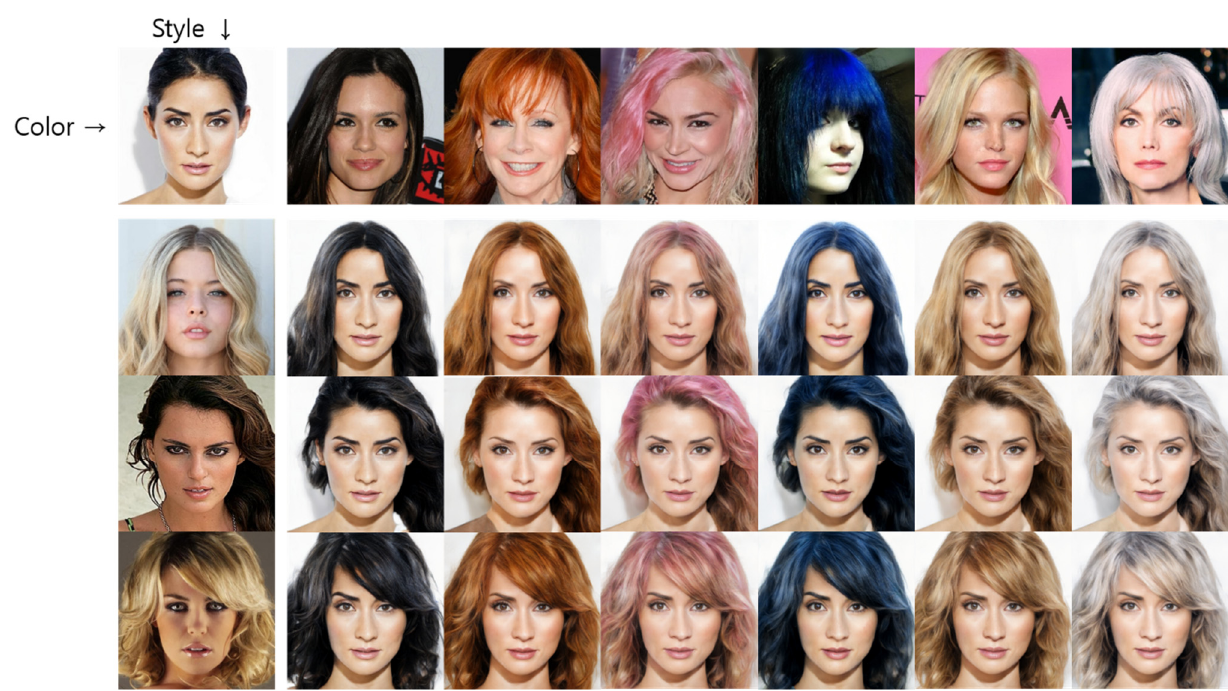
Figure 12. Left image: style; top image: color. High-quality composite images are displayed in various styles and images by synthesizing various styles and colors based on the first facial figure.